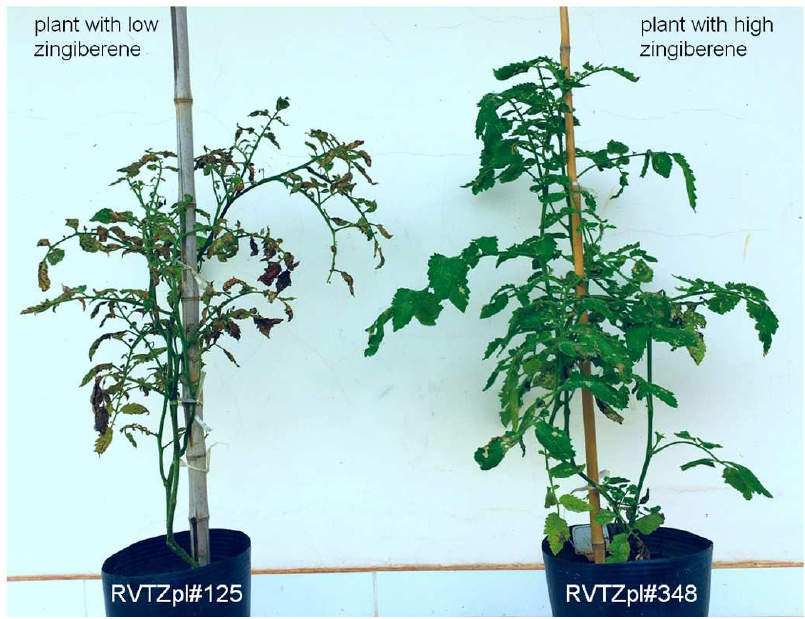
Figure 4. Level of damage caused by tomato moth on low zingiberene (RVTZpl#125) and high (RVTZpl#348) tomato genotypes selected from BC 3 F 2 backcross.